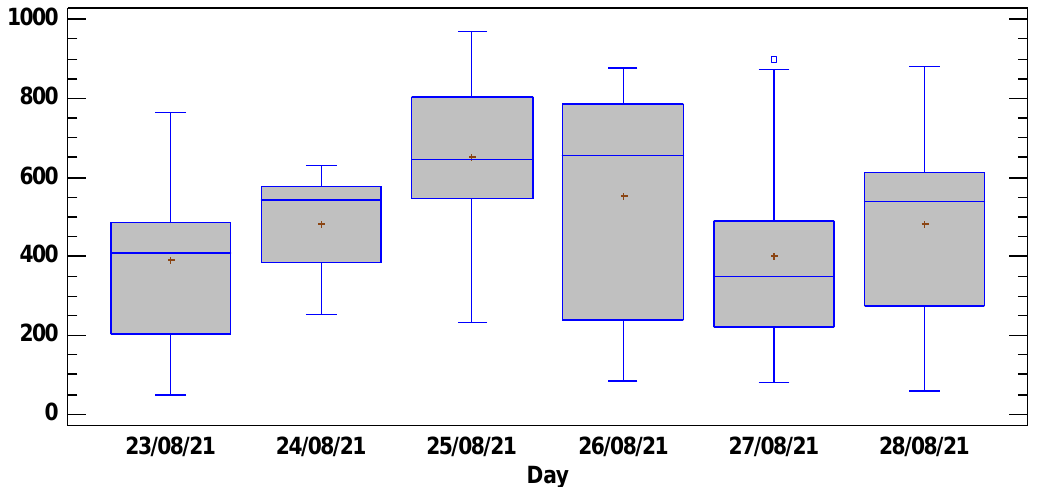
Figure 7. Solar radiation in the study area during test days. The central value of the box-and-whisker plot is the median of the data, the “+” represents the mean, and the lower and upper borders correspond to the first and third quartiles, respectively. Finally, the ends of the whiskers correspond to the minimum and maximum values of the analyzed data.